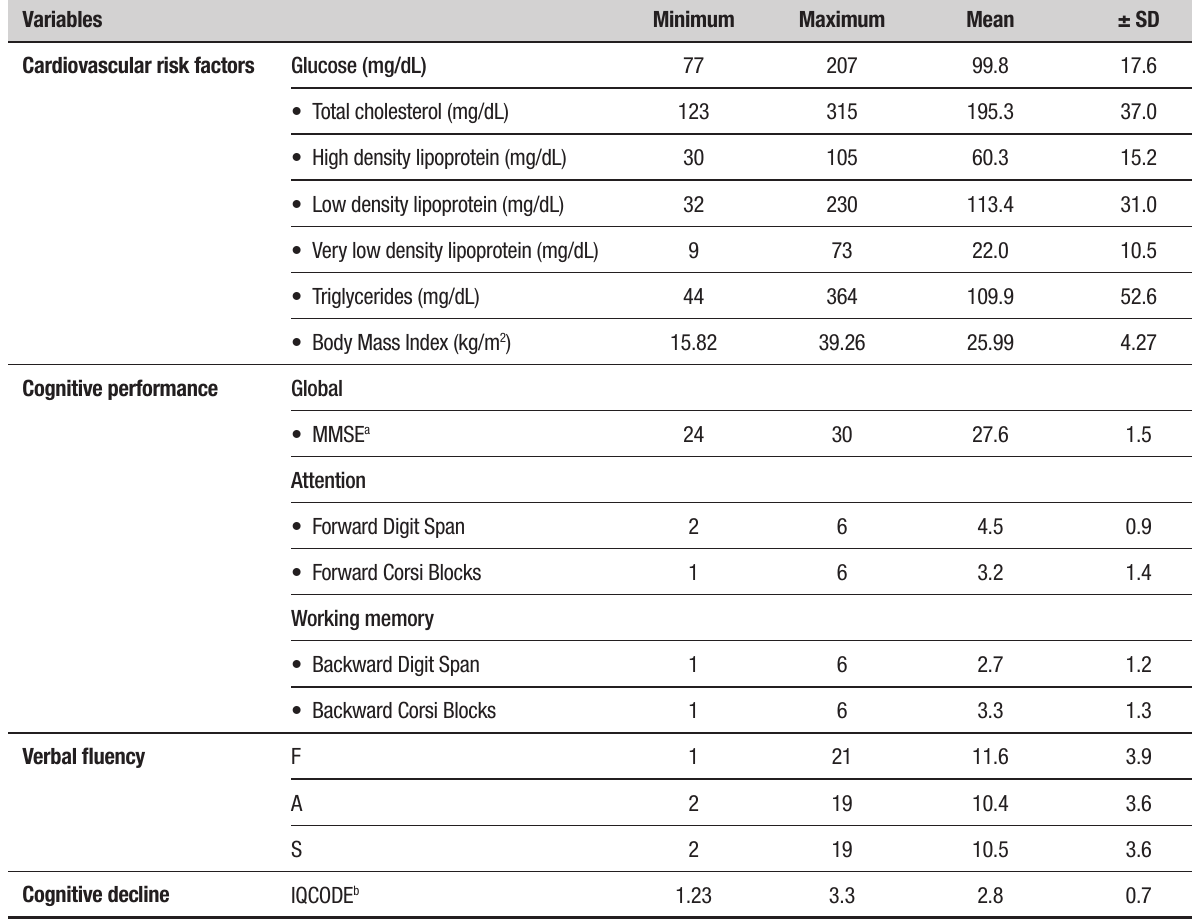
Table 1. Sample characteristics according to cognitive and functional performance and cardiovascular risk factors. Variables